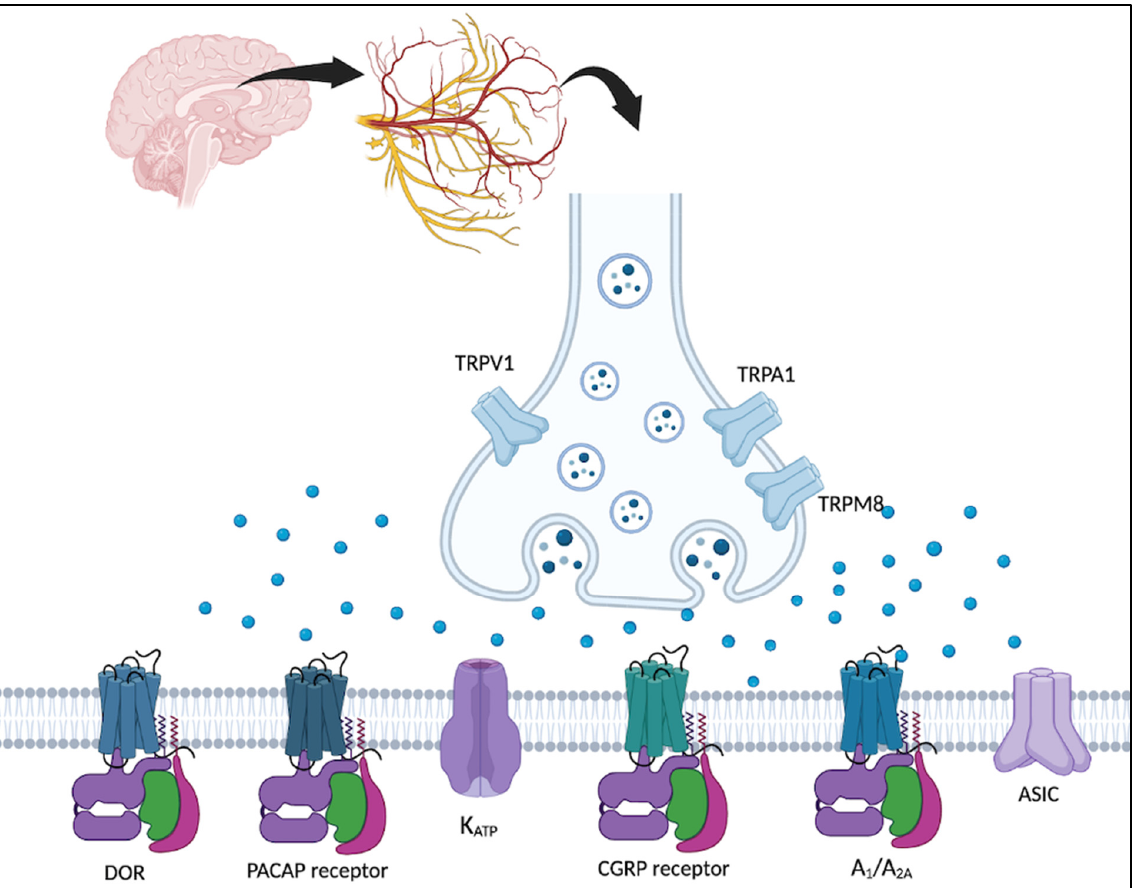
Figure 1. Illustration of several potential therapeutic targets under investigation for migraine man- agement. Adenosine receptors (A 1 /A 2A ), Pituitary adenylate cyclase-activating polypeptide (PACAP) receptor, δ -opioid receptor (DOR), calcitonin gene-related peptide (CGRP) receptors are G-protein coupled receptors, whereas Acid-sensing ion channels (ASIC), transient receptor potential channels (TRP), and potassium channels (K ATP ) are ion channels.